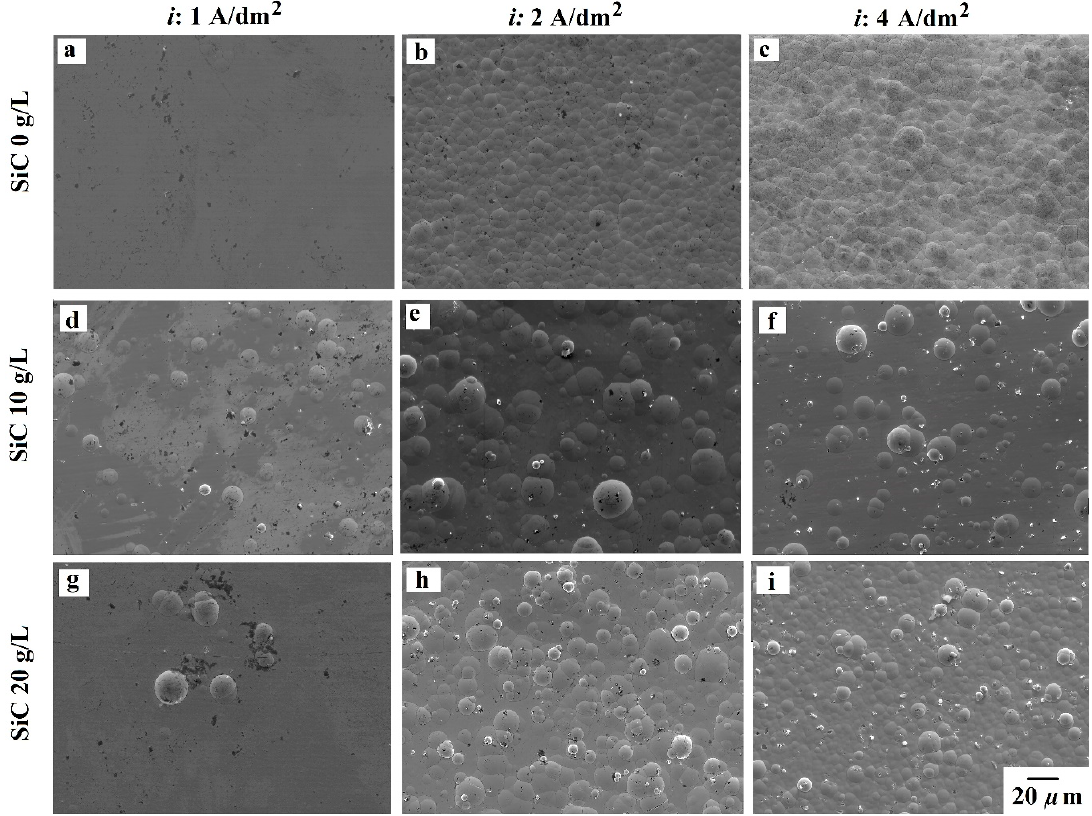
Figure 5. SEM images of the surface of ( a – c ) NiP, ( d – f ) NiP/10SiC, ( g – i ) NiP/20SiC. ( a , d , g ) i : 1 A/dm 2 , ( b , e , h ) i : 2 A/dm 2 , ( c , f , i ) i : 4 A/dm 2 deposited from bath 3.